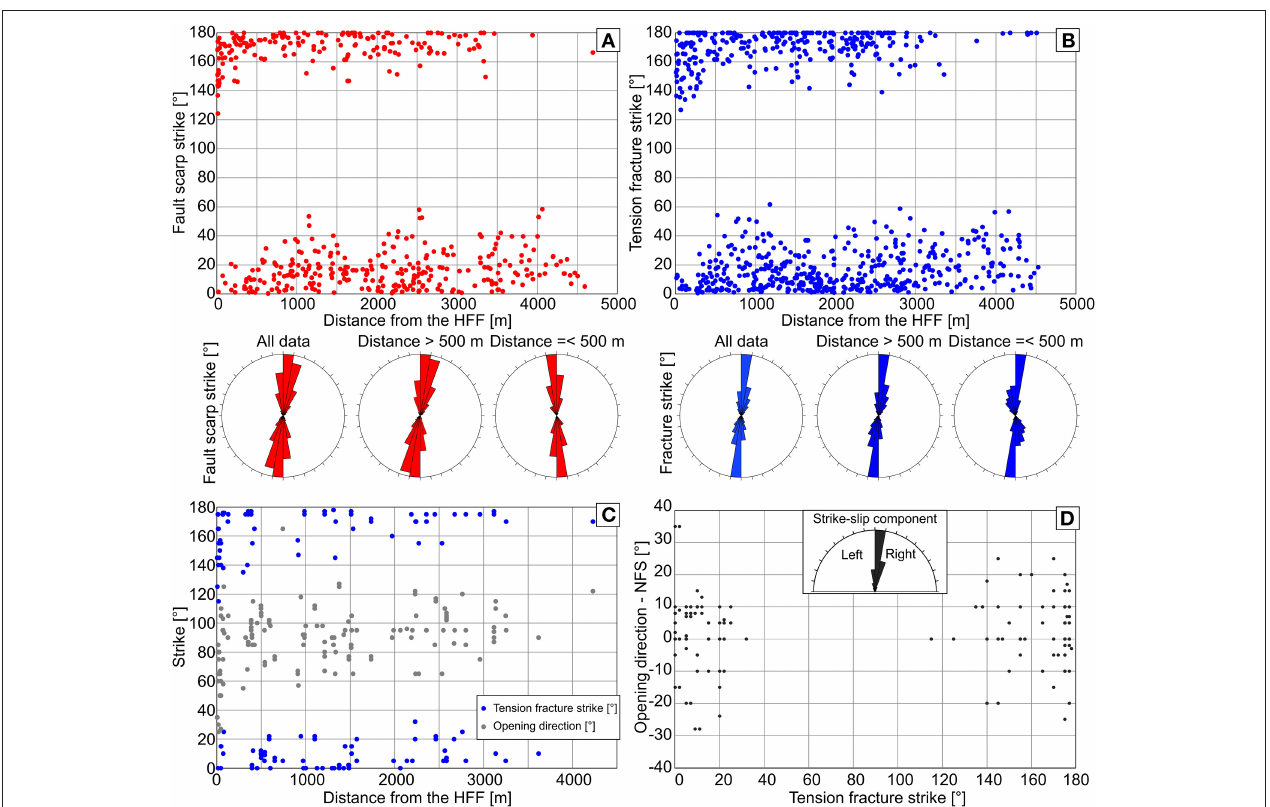
FIGURE 4 | Structural data measured along the TFS. (A) Plot of the distribution of fault strikes measured in the field and on high-resolution satellite images (total = 434; Y axis), vs. the distance from the HFF prolongation in meters ( X axis). Such distance is defined as the minimum distance from the surface projection of the fault (e.g., Bindi et al., 2011). Below the graph, rose diagrams with fault strike distribution are provided. (B) Plot of distribution of tension fracture strike measured in the field and on high-resolution satellite images (total = 722) ( Y axis), vs. distance from the HFF prolongation in meters ( X axis). Below the graph, rose diagrams with tension fracture strike distribution are provided. (C) Plot of distribution of opening directions measured in the field (total = 141) along tension fractures, vs. distance from the HFF prolongation in meters ( X axis). (D) Graph of tension fracture strikes measured in the field (total = 141; Y axis), vs. the angle between the opening directions and the normal to the fracture strike (NFS). Positive values indicate a right-lateral component of the opening direction, negative values show a left-lateral